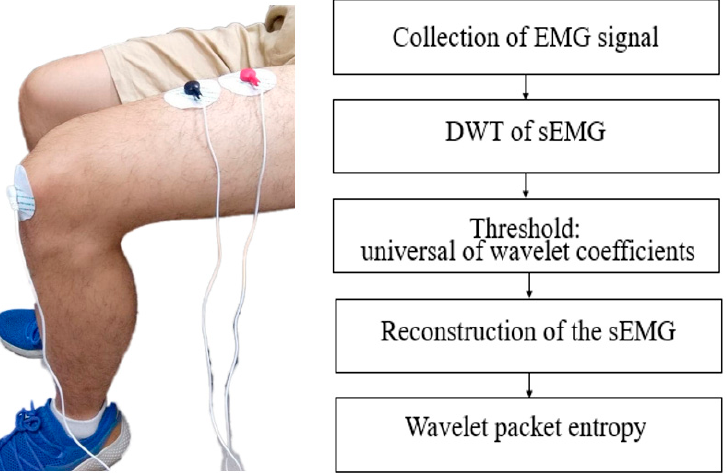
Figure 5. Processing the EMG signal to entropy.